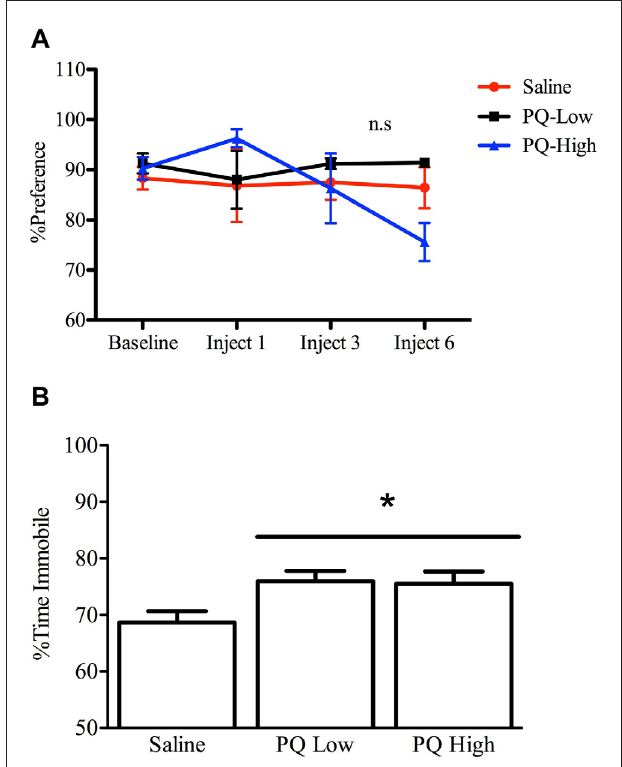
FIGURE 4 | Dose-dependent effects of short term paraquat exposure on force swim immobility but not sucrose preference. As shown in (A) , short term low dose (PQ-Low; 1 mg/kg) or high dose (PQ-High; 10 mg/kg) paraquat exposure did not influence sucrose preference at any time point (n.s = not significant). As shown in (B) , both the 1 and 10 mg/kg doses of paraquat effectively increased the time immobile in a forced swim test. ∗ p < 0.05, relative to saline treated